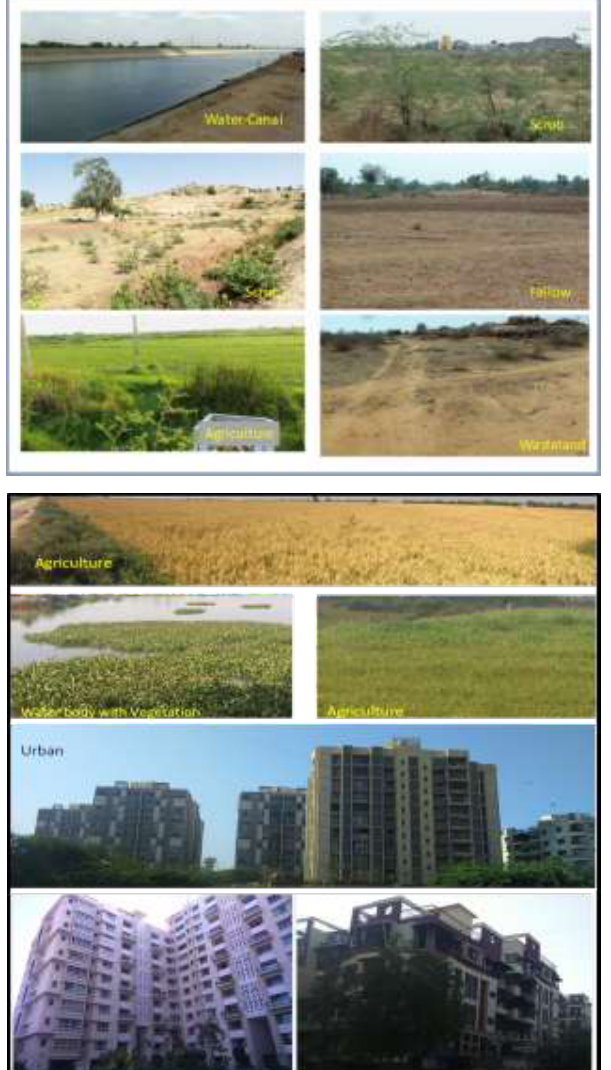
Figure 4. Ground Truth of various LULC FCC of LISS-IV data